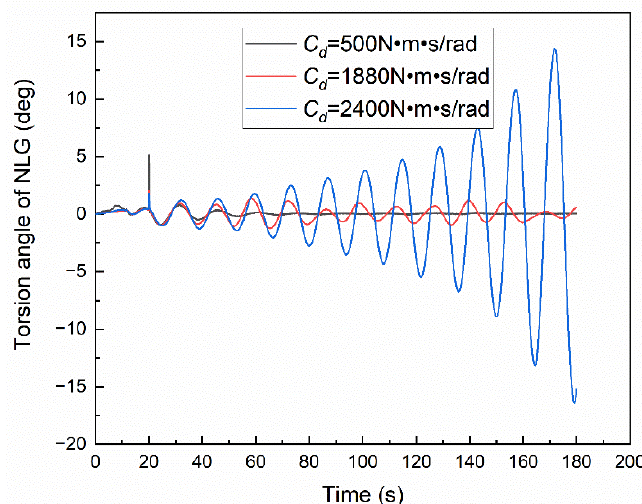
Figure 6. Effect of torsional damping on aircraft yaw rate.